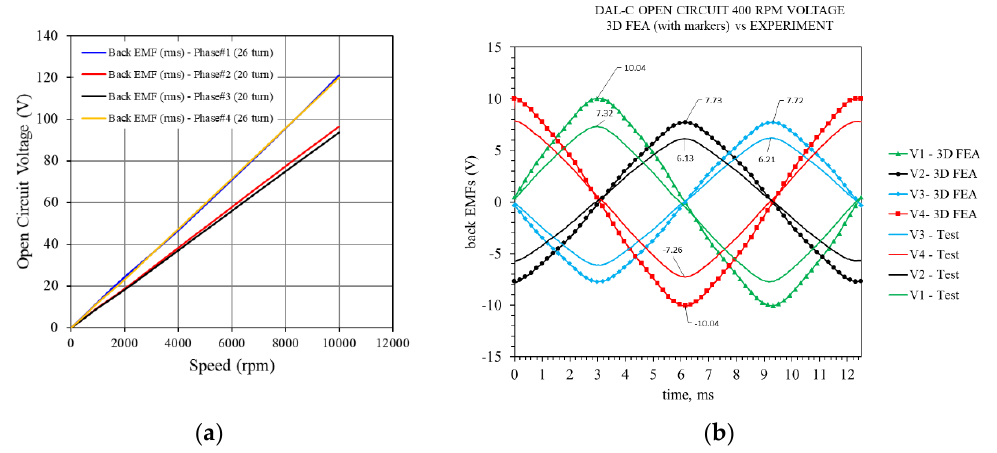
Figure 12. Open circuit test results: ( a ) Open circuit voltage vs. mechanical speed (rpm)—experimental, ( b ) 3D FEA vs. Experiments at 400 rpm.